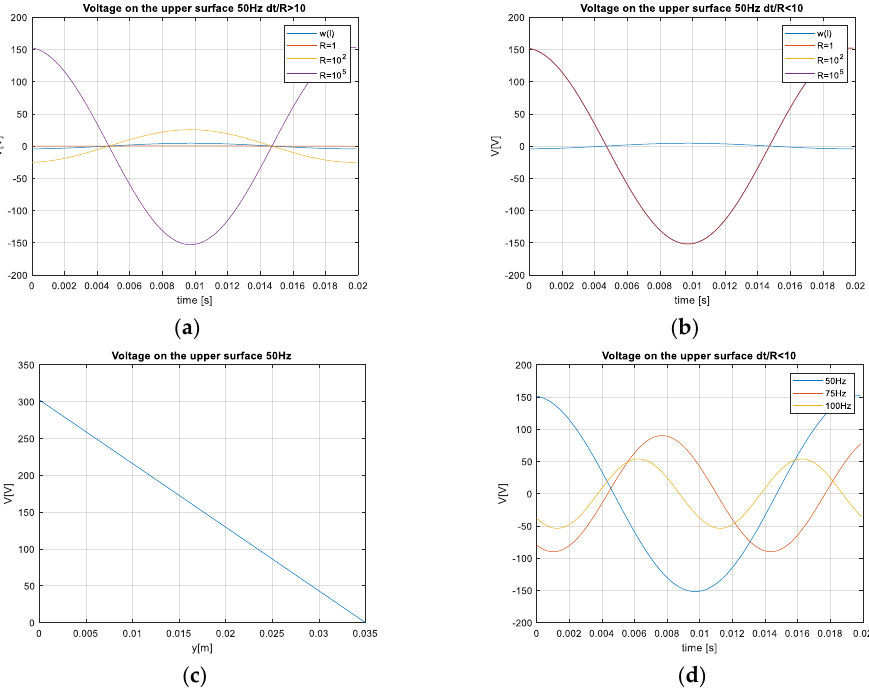
Figure 8. Voltage – time behavior on the upper surface of the PZT layer at different resistance values in correspondence with ∆t/R L >10 ( a ) and ∆t/R L <10 ( b ). Voltage – space behavior along the support axis ( c ). Voltage – time behavior at 50 Hz, 75 Hz, and 100 Hz on the upper surface of the PZT layer ( d ).